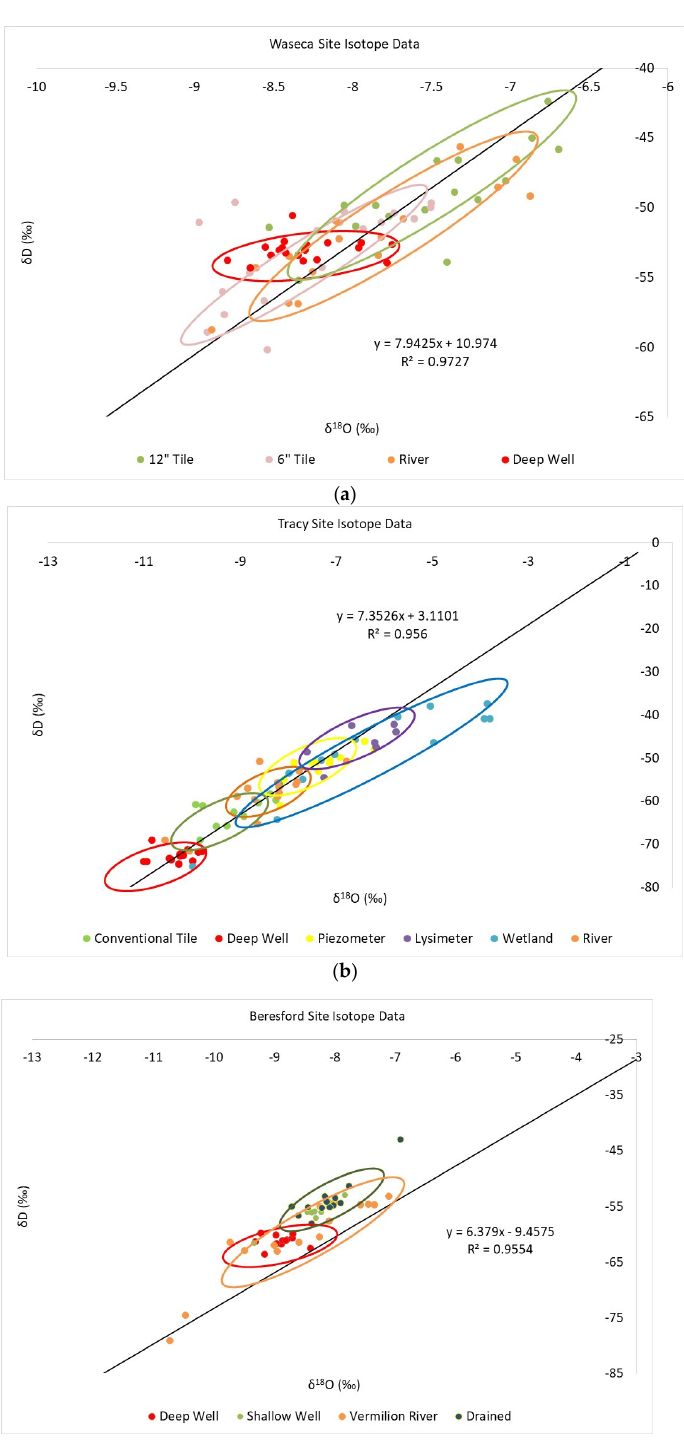
Figure 4. LMWL and water sample isotope plots for each site. ( a ) Waseca site; ( b ) Tracy site; ( c ) Beresford site. Among the three sites, the Tracy site data deviated the most. The differences between sampling locations are very well demonstrated on the Figure 4b. Wetland and deep well data lie on the opposite ends of the plot. They show the most difference in isotopic com- position. The wetland water showed more of an evaporative signature than the rest of the locations, which is typical of surface water evaporation. The wetland water isotopic sig- nature ranged from deep well to evaporative water. It is likely that the wetland received groundwater input to sustain the long-term standing water table. The deep well water had the least evaporative signature. Waseca and Beresford site data points plotted more tightly than Tracy. Field investi- gation suggested that at Waseca, the 6 ″ tile drain conveyed shallow groundwater. There- fore, it is not surprising that the isotopic signatures from the 6 ″ tile drain were similar to the deep well. River and tile drain data both showed evidence of evaporation with the tile drain water showing a little more evaporative influence. The deep well and the 6 ″ tile drain isotopic signatures intercept with all the other locations. A groundwater isotope signature was present at all other locations. Compared to the Tracy site, groundwater ap- pears to play a larger role on the watershed hydrologic characteristics. Beresford had almost all the water samples plot above the LMWL. This is not com- monly seen, but not impossible. The literature suggests that this phenomenon happens in low humidity regions when re-evaporation of precipitation increases water vapor masses with an even lighter isotopic composition [51]. Groundwater also appeared to have a sig- nificant influence upon the river water signature of this watershed. 4.2. EMMA The two-component hydrograph separation model was applied to all three sites. The number of endmembers that can be solved is limited by the number of variables measured due to mathematical limitations. The results are shown in Figure 5. Uncertainty existed in the two-component model, which was quantified using a sensitivity analysis. River sam- pling locations were chosen to be far away from the tile drain outfall and groundwater seepage points to minimize the impact of any partial mix. The analysis assumed that the streamflow was a well-mixed system. Based on field observation, on days with no precipitation, tile drain flow and ground- water seepage were the major inputs to streamflow. Other minor inputs include surface